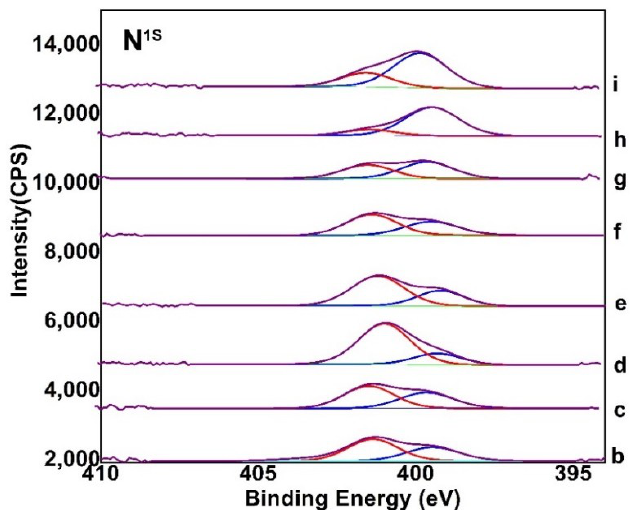
Figure 4. The deconvolution of the peaks in XPS N 1s spectroscopy of RGO ( b : ORGO at 35 °C, 0.5 h; c : ORGO at 35 °C, 5 h; d : ORGO at 50 °C, 0.5 h; e : ORGO at 50 °C, 5 h; f : ORGO at 80 °C, 0.5 h; g : ORGO at 80 °C, 5 h; h : ORGO at 120 °C, 0.5 h; i : ORGO at 120 °C, 5 h), the red line was deconvolution